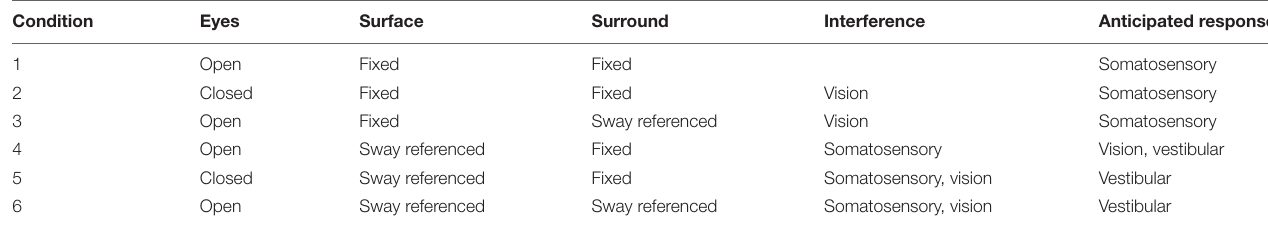
TABLE 1 | Sensory organization